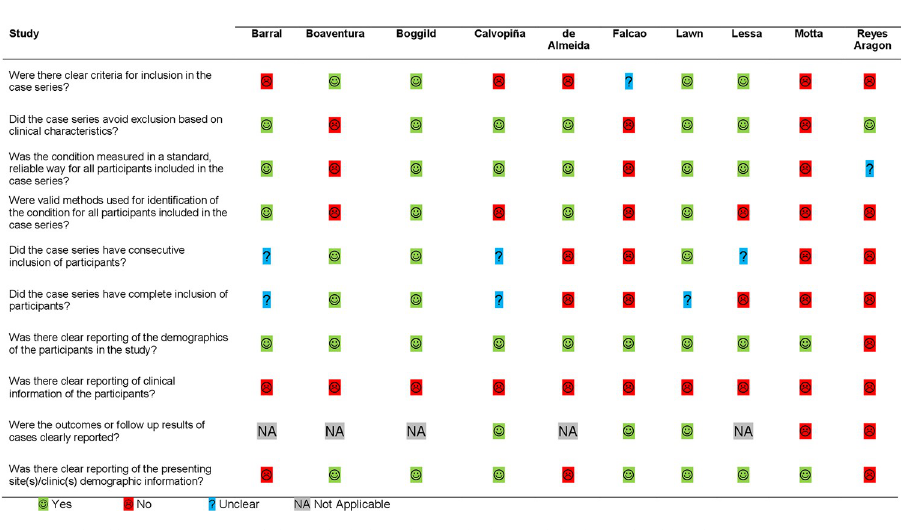
Fig 2. Risk of bias assessment of the included studies with the modified JBI checklist for case